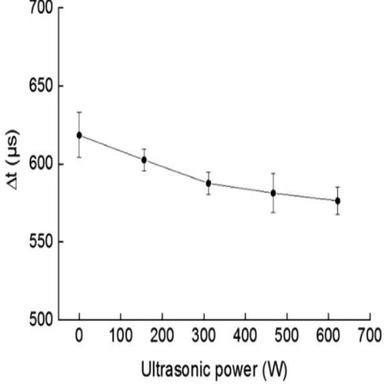
Influence of the ultrasonic power on the moment of the initial signal detected below the hole exit during the process of single-pulse laser drilling.